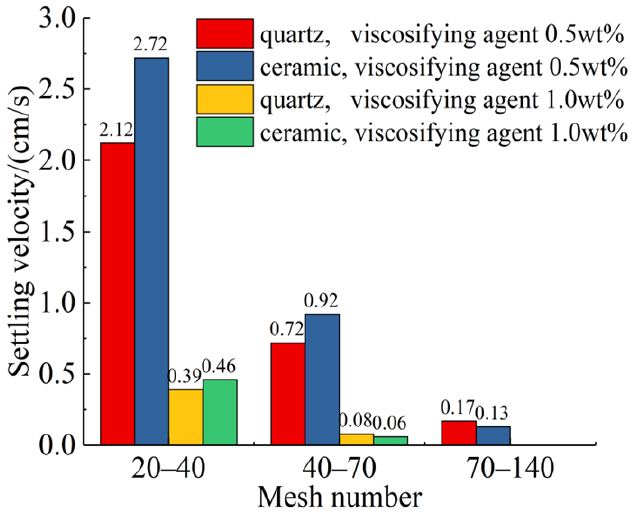
Figure 5. Proppant settling.